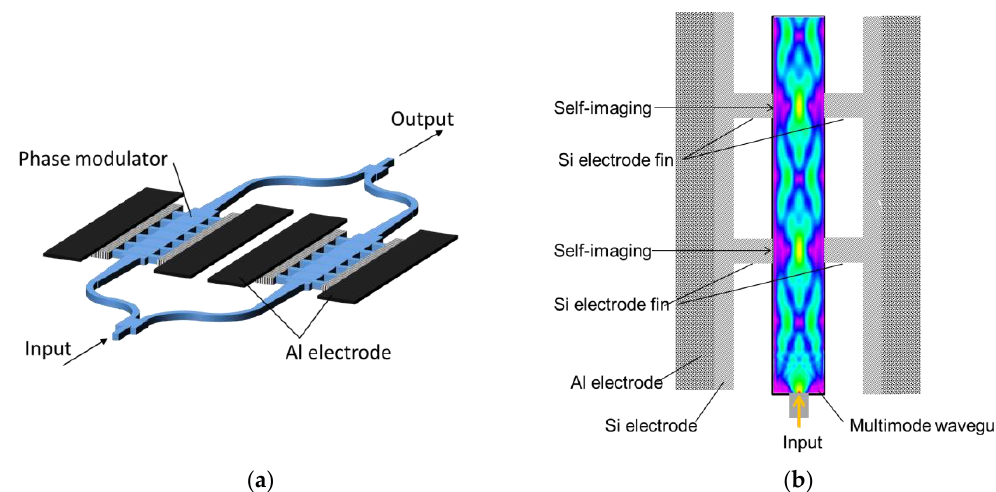
Figure 1. Schematic of ( a ) a Mach–Zehnder interferometer modulator with a multimode interferometer (MMI) phase modulator, and ( b ) a phase modulator based on MMI.